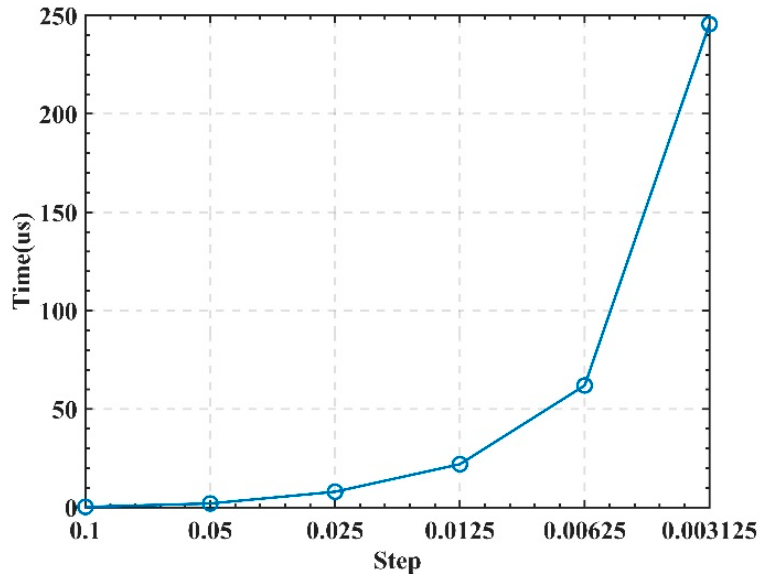
Figure 3. Running time of algorithms with different step sizes.